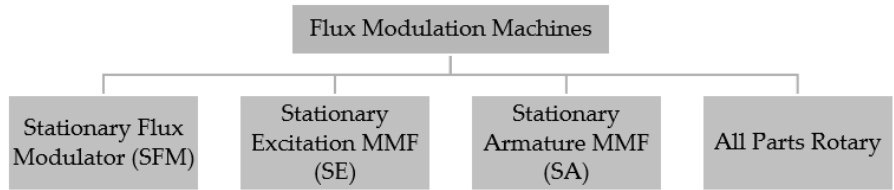
Figure 3. Classifications of flux modulation machines.